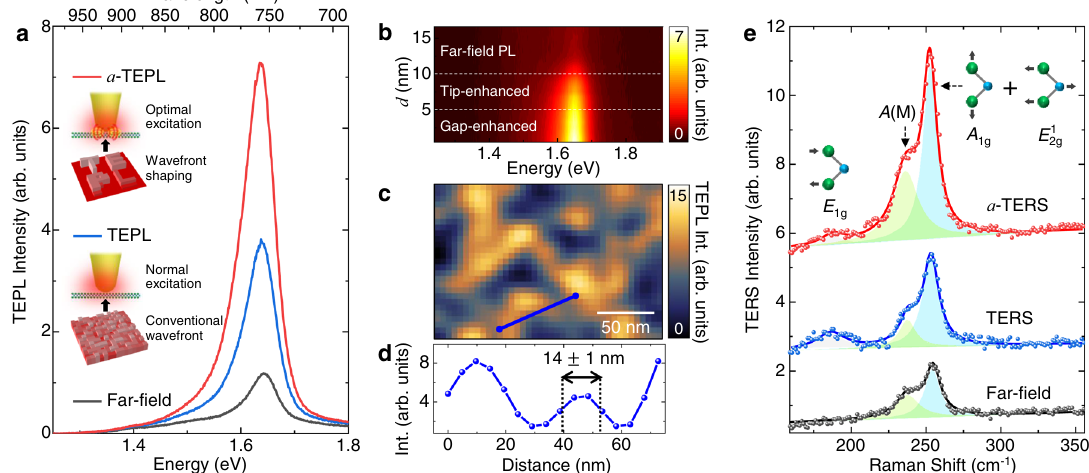
Fig. 3 Augmented TEPL and TERS responses through the wavefront optimization process. a Comparison of far- fi eld PL (black) and TEPL spectra of a WSe 2 monolayer without (blue) and with wavefront shaping ( a -TEPL, red). b Evolution of a -TEPL spectra as a function of distance d between Au tip and the crystal (WSe 2 monolayer), exhibiting gradual PL enhancement through the tip-enhanced and gap-enhanced regions. c a -TEPL image of a WSe 2 monolayer on Au fi lm, and ( d ) a -TEPL intensity pro fi le indicated as a blue line in Fig. 3c, showing a spatial resolution of ~14 nm. The same Au tip and sample were used for the results of Fig. 3a – d. e Comparison of far- fi eld Raman (black) and TERS spectra of a WSe 2 monolayer without (blue) and with wavefront shaping ( a -TERS, red) with Lorentz pro fi le fi t. Raman active E 1g , A (M), and A 1g + E 1 modes are observed. See SI for real PMs we used for the 2g measurements ( a ) and ( e